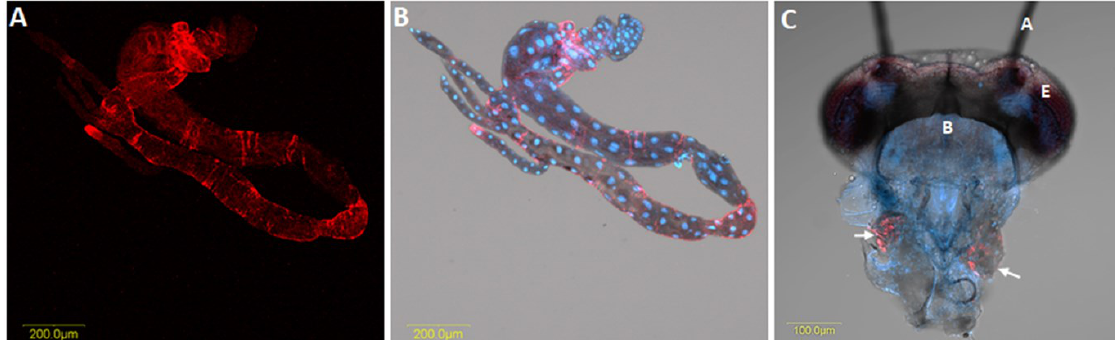
Figure 4. Localisation of Liberibacter solanacearum (CLso) in the midgut of an adult psyllid ( A , B ) and in salivary glands ( C ), using fluorescence in situ hybridisation (FISH). A (dark field), B (bright field) and C (bright field of an adult head) show the localisation of CLso (red) as a stripe-like pattern in the midgut and a scattered pattern in the salivary glands (white arrows). Blue in all images is DAPI staining of the nuclei. A, antennae; E, eyes; B, brain.